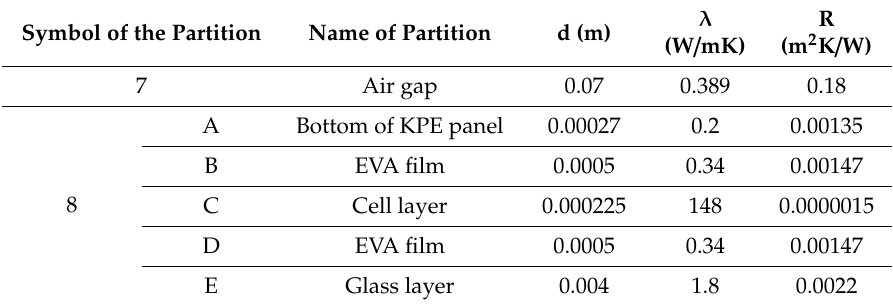
Table 4. Parameter values for new material layers after modernization [69,71].